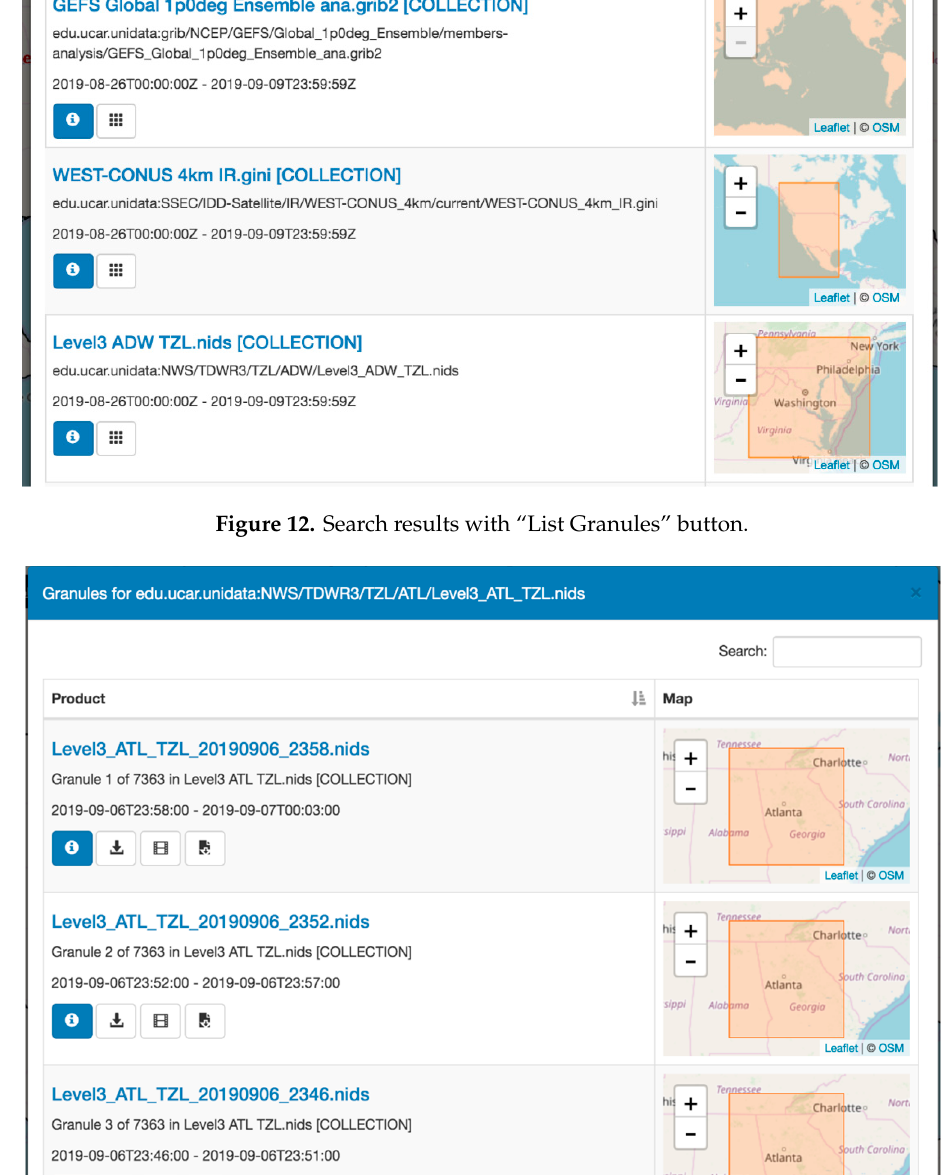
Figure 13. Granules list for a collection. The buttons allow users to view metadata, download the dataset, or visualize it.